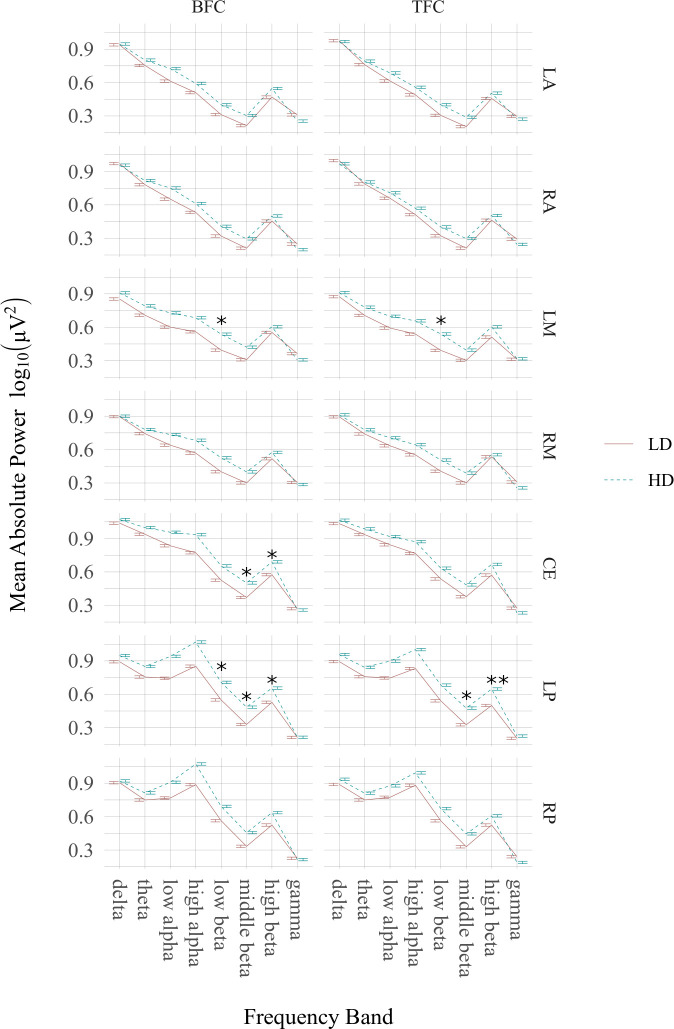
Comparisons of particular frequency band power (key as in previous figure) between patients with high (HD) and low (LD) tinnitus-related distress in selected clusters (key as in previous figure).The significant differences are marked with “stars” (* p < 0.05, ** p < 0.01).